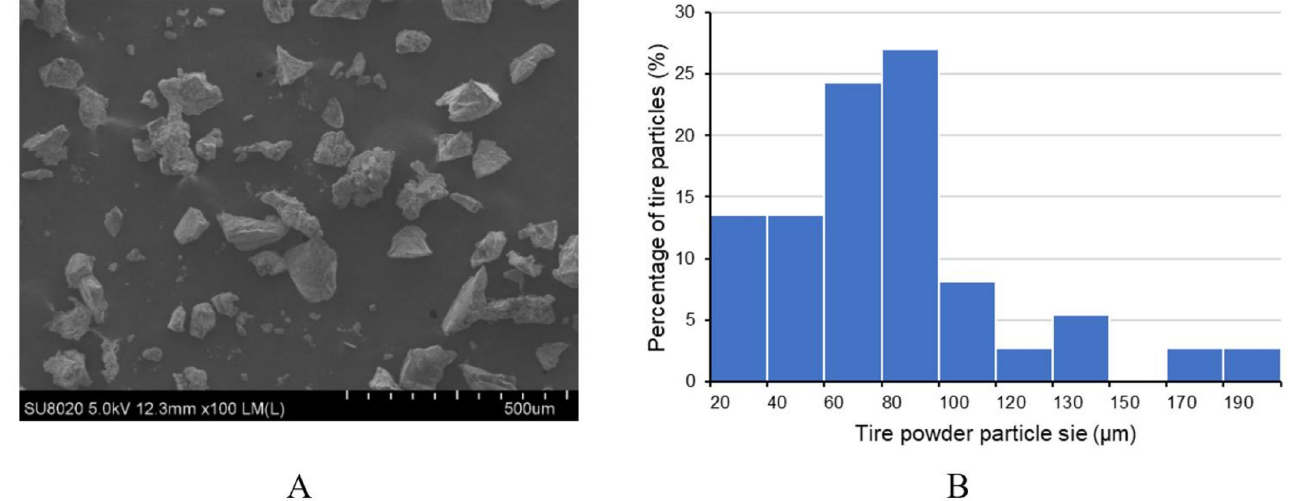
Figure 2. SEM micrograph of micronized TR powder ( A ) and TR particle size distribution ( B ).